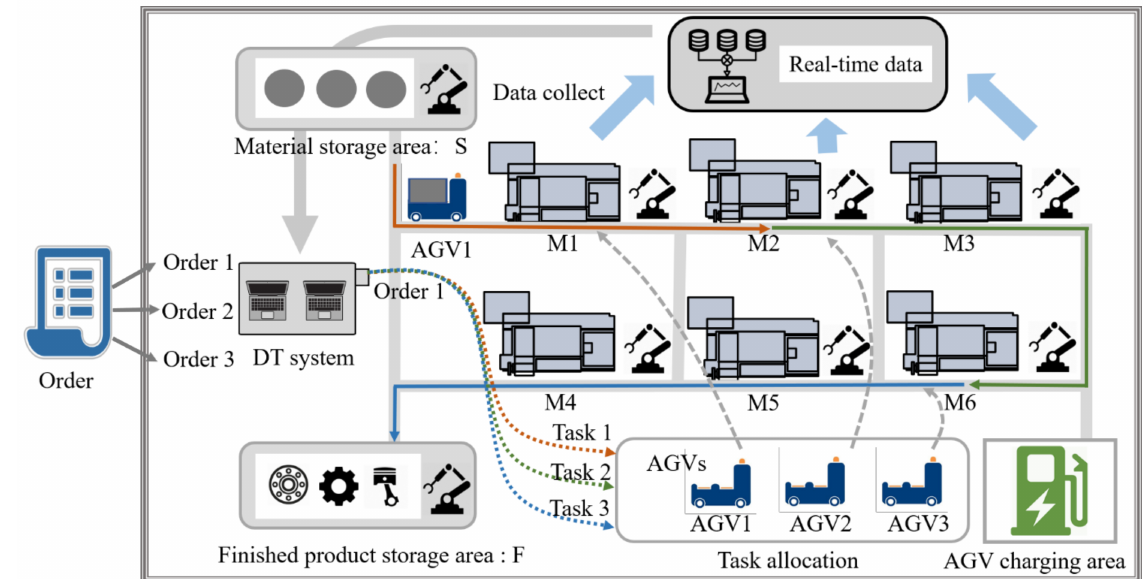
Figure 2. The layout of the manufacturing workshop.